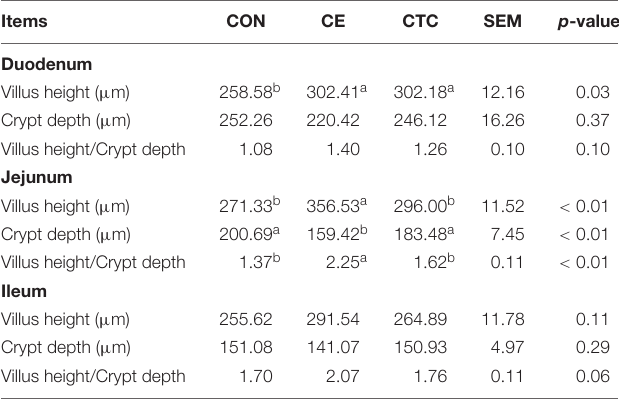
TABLE 7 | Effect of CE on intestinal morphology of weaned piglets.